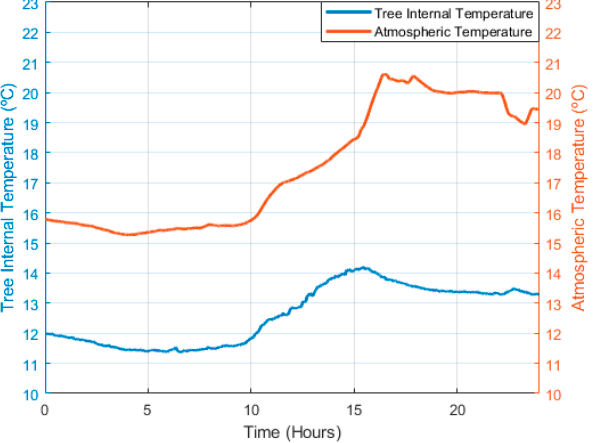
Figure 10. Internal and external tree temperature [ ◦ C] evolution over time—Experimental test